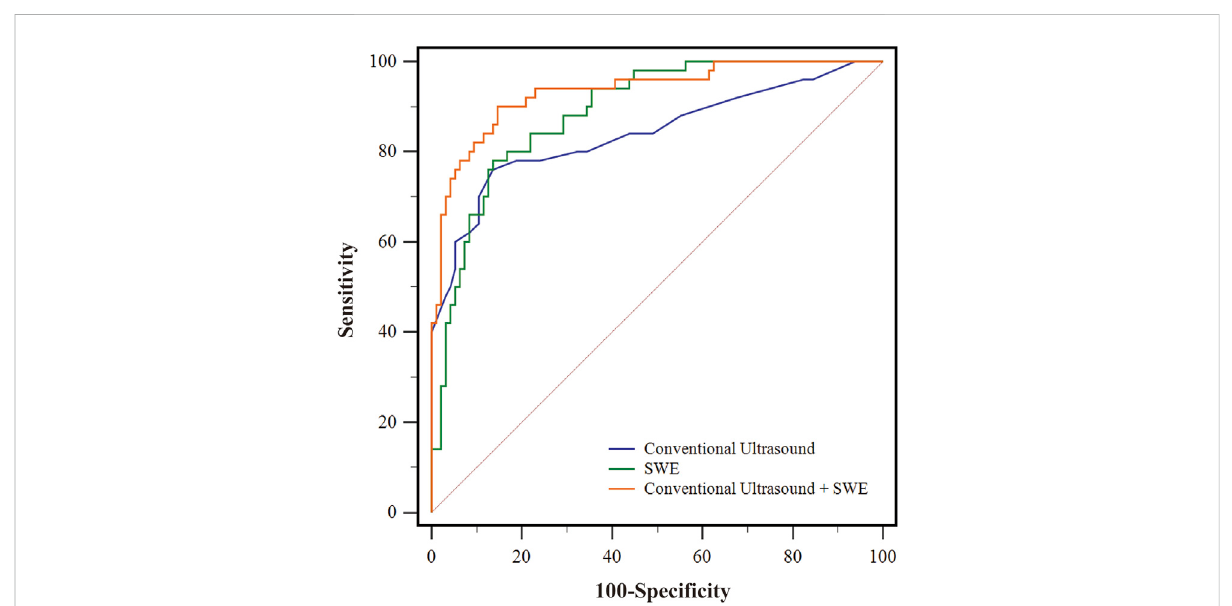
FIGURE 3 The receiver operating characteristic (ROC) curves of different evaluation method for screening early-stage plantar fasciopathy. The blue line representstheROCcurveofconventionalultrasound.ThegreenlinerepresentstheROCcurveofSWE.TheorangelinerepresentstheROCcurveof conventional ultrasound +